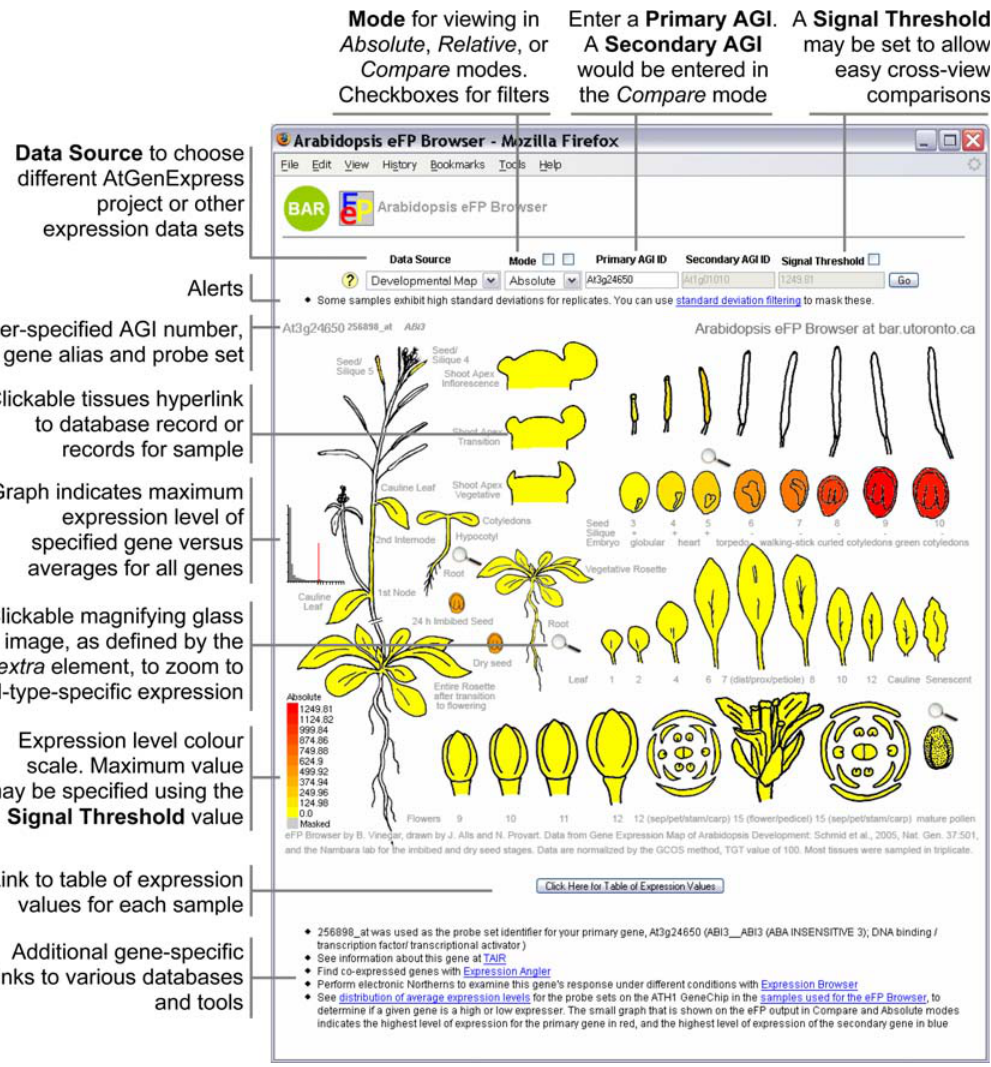
Figure 2. Expression pattern of ABI3– ABSCISICACIDINSENSITIVE3. ABI3 , At3g24650, is expressed strongly in Stage 8–10 seeds. Features and control options of the Arabidopsis eFP Browser are also